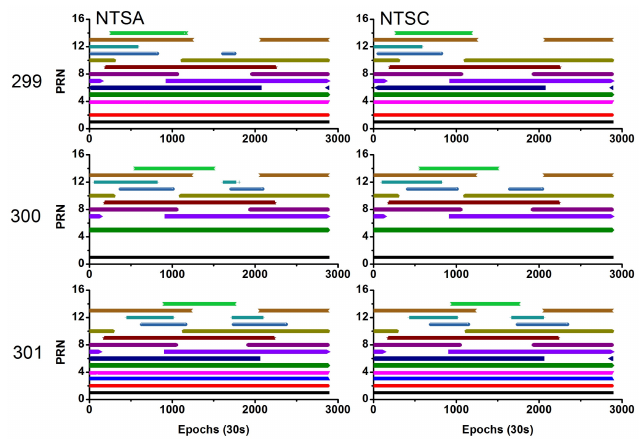
Figure 1. PRN (pseudo random noise code) of the visible BeiDou Navigation Satellite System (BDS) satellites during the experiment ( left side represents NTSA station, and the right side represents National Time Service Center (NTSC) station).